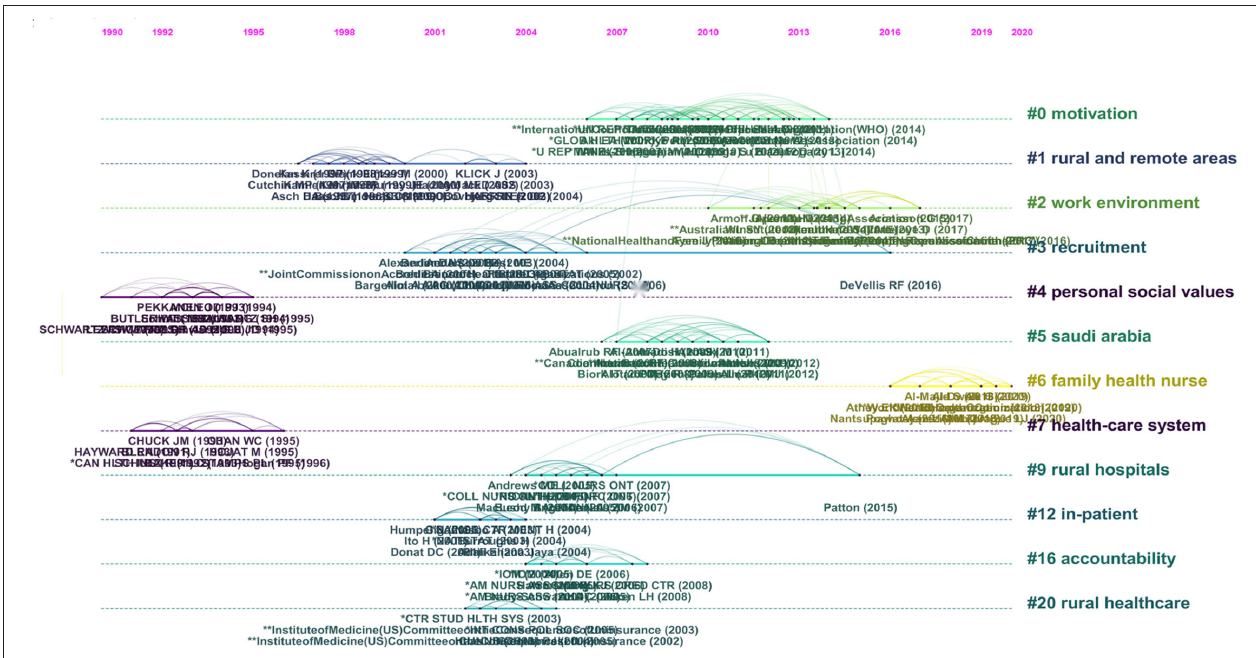
FIGURE 5 | The timeline view of the knowledge map is based on reference co-citation